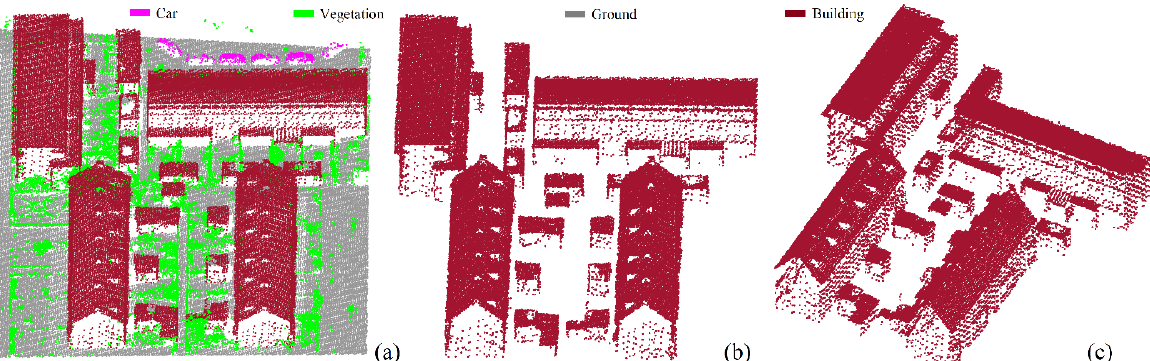
Figure 5. (a) Labelled AHN data set, (b) front-view of the buildings to extract footprint, (c) side-view of the